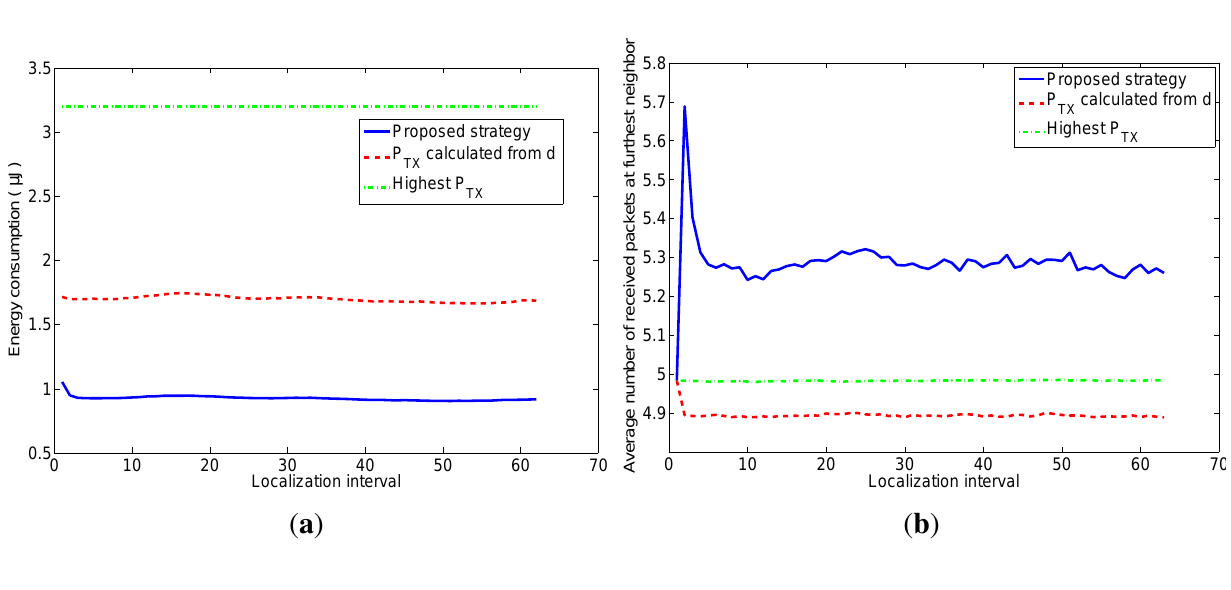
Figure 9. Average energy consumption and average number of received packets at the furthest node of the three strategies for each localization interval for an environment with shadowing.